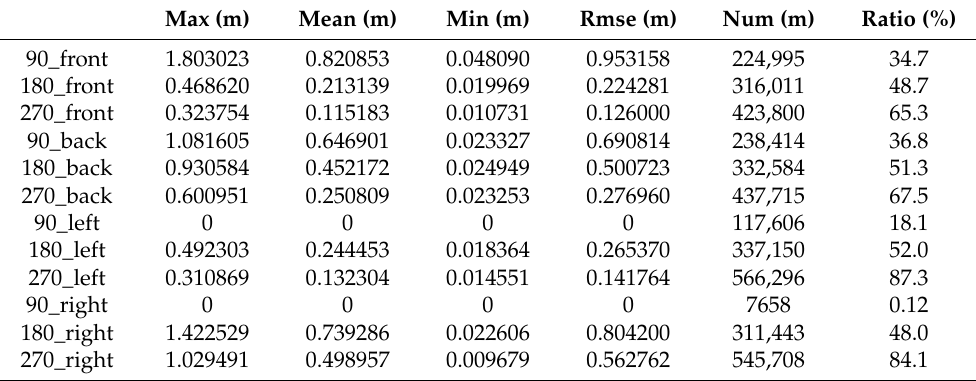
Table 1. Absolute track error in four directions.